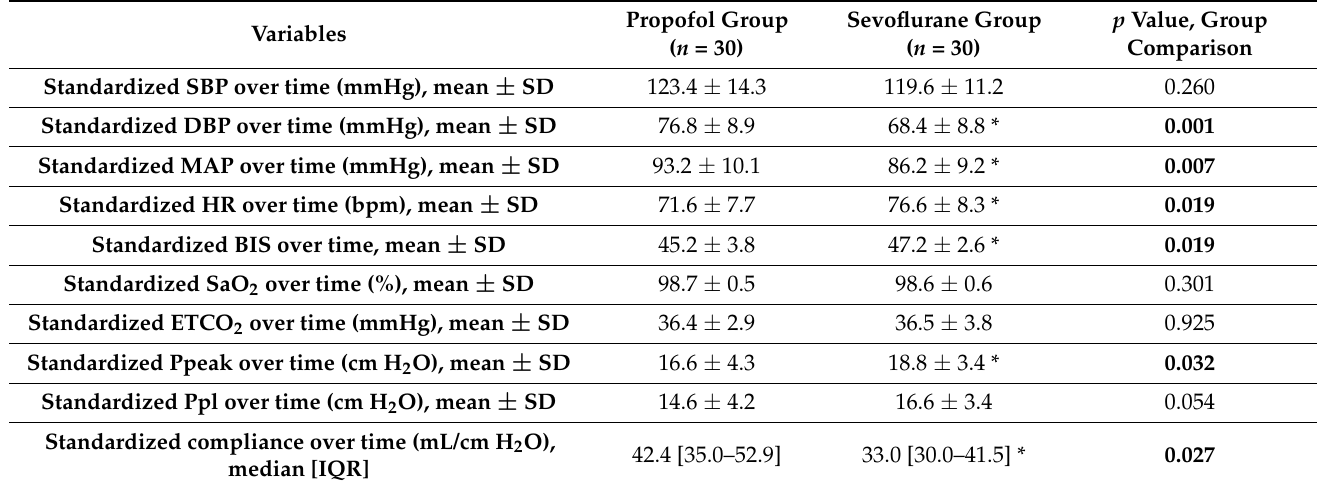
Table 2. Standardized values for serial variables and comparisons between the two groups. * sig- nificant difference between groups .